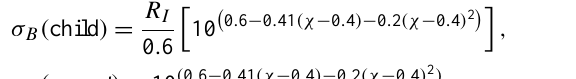
along the same line (with the exception of the